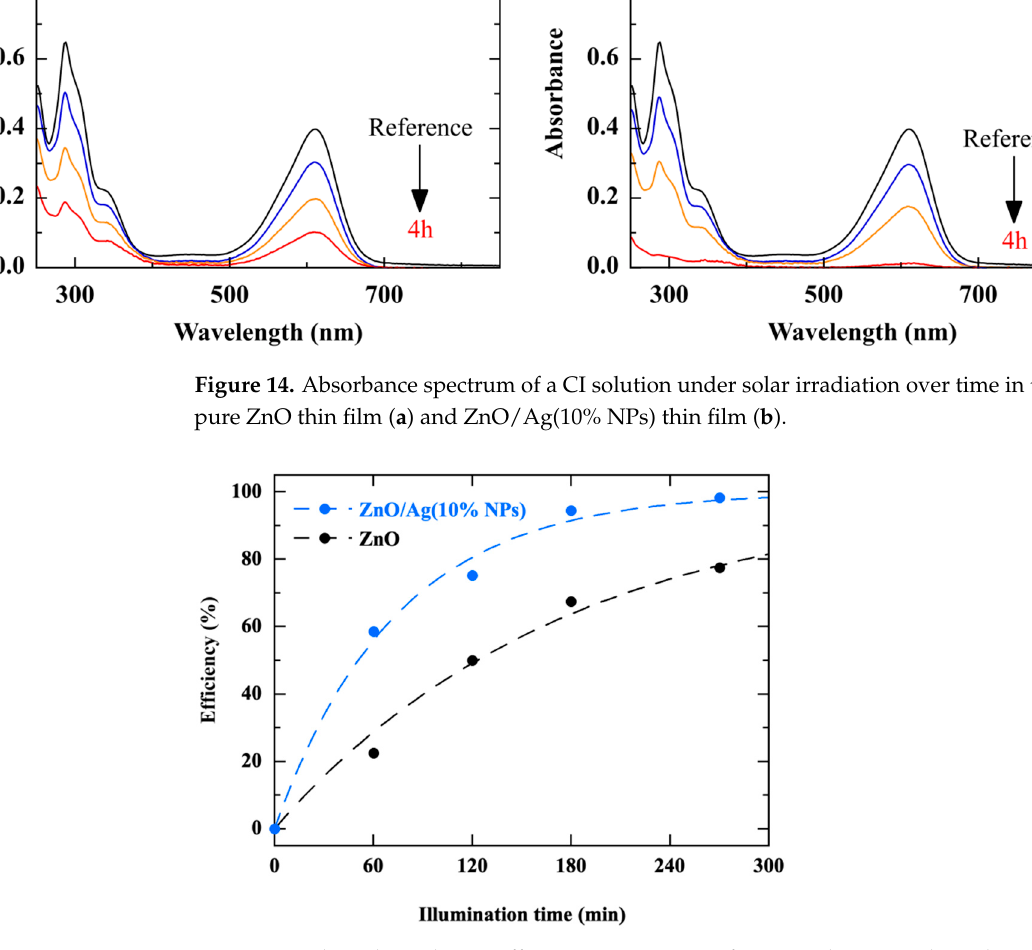
Figure 15. Photodegradation efficiency, over time, of an IC solution under solar irradiation by a ZnO/Ag(10% NPs) thin film and by a pure ZnO film. The curves are provided as guides for the eye.